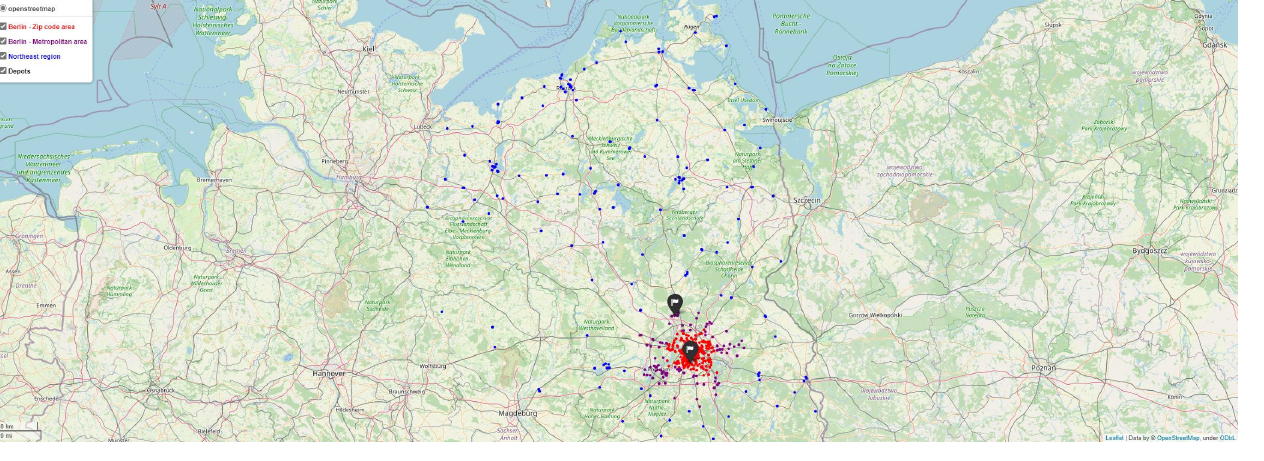
Figure 1. Data sample—Maps of the northeast region of Germany. Points represent individual retail stores; Red: Retail stores in the Berlin zip code area (share: 50%); Purple: Berlin metropolitan area (40 km) (share: 20%); Blue: Other retail stores (share: 30%)—own illustration based on leaflet.